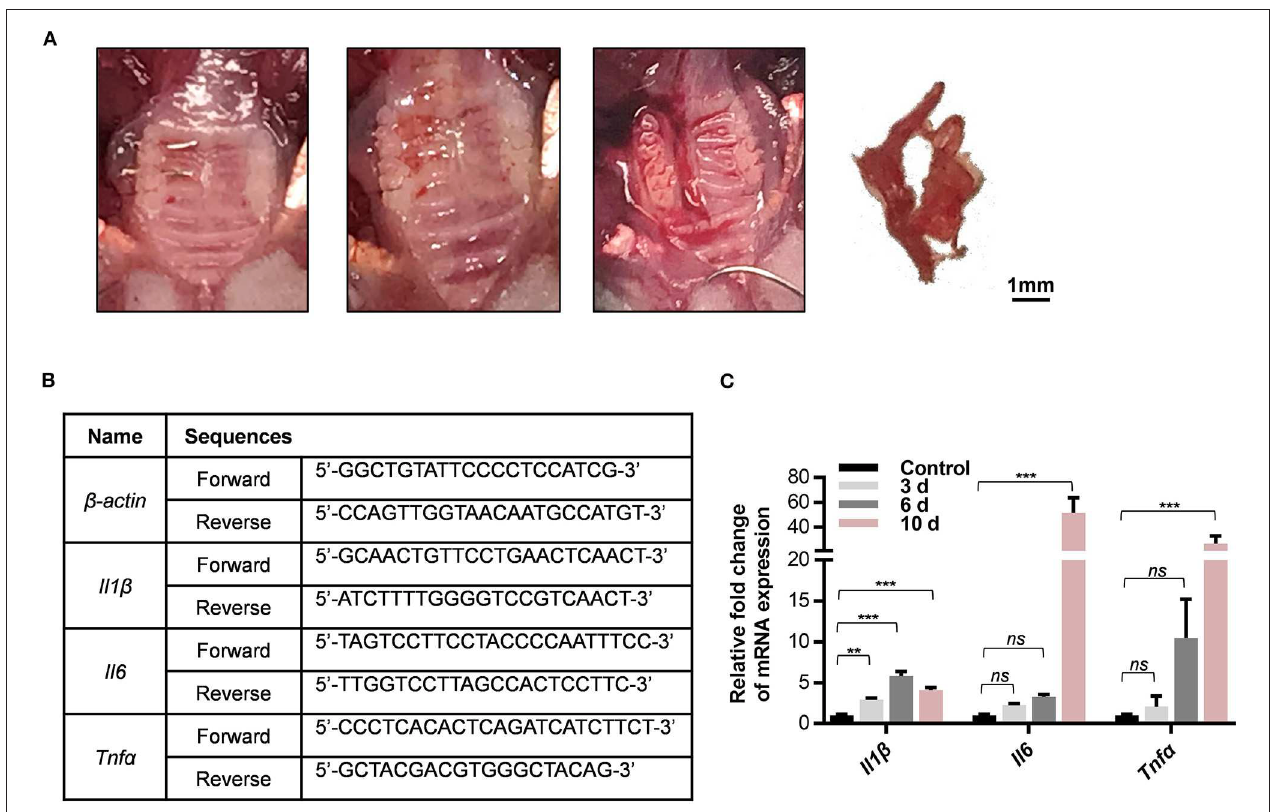
FIGURE 4 | The new method for periodontitis induction increases expression of inflammatory gene in periodontal tissues. (A) Collection of gingival tissues around the ligature side of maxillary molars. (B) Sequences of gene-specific primers used in qPCR analysis. (C) The mRNA levels of Il1 β , Il6, and Tnf α in whole gingival tissues including on 0, 3, 6, and 10 days after ligature-placed sites were determined by qPCR experiments. Results are shown as fold increase relative to the control tissues without experimental periodontitis treatment in mean ± SD. (** P < 0.01, *** P < 0.001, ns, not significant, n = 3, One-way ANOVA, Tukey’s multiple comparisons